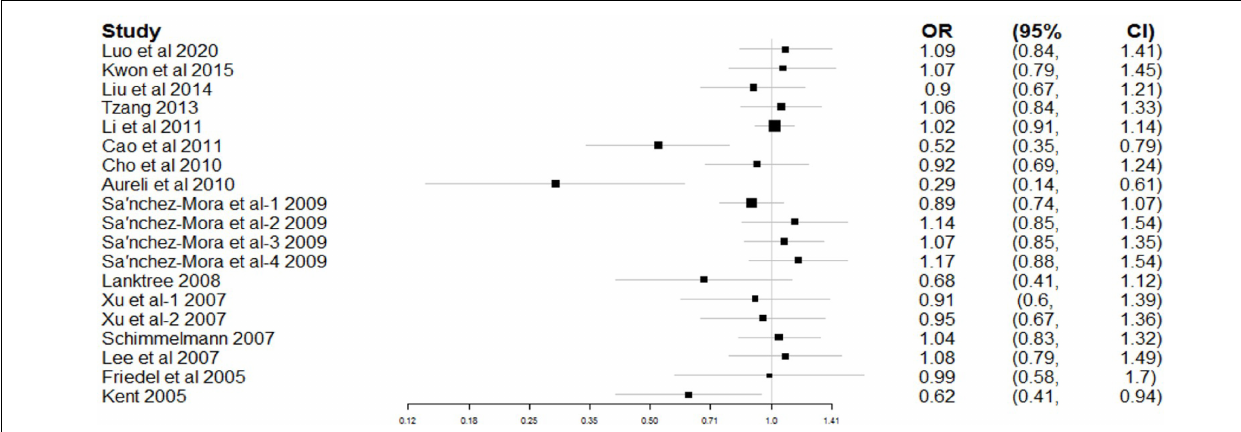
FIGURE 2 | Forest plot for the association between rs6265 and attention deficit hyperactivity disorder (ADHD)